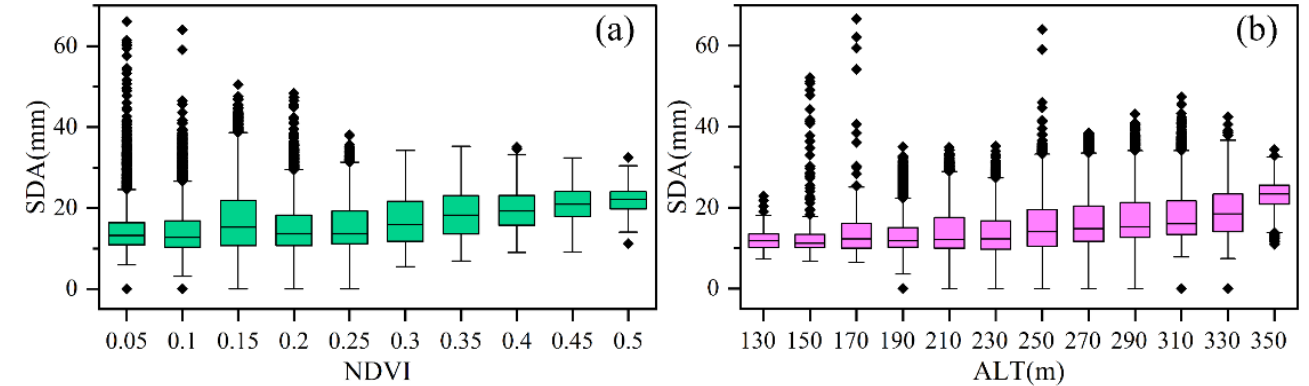
Figure 10. The relationship between NDVI ( a ) and active layer thickness ( b ) and seasonal deformation amplitude.